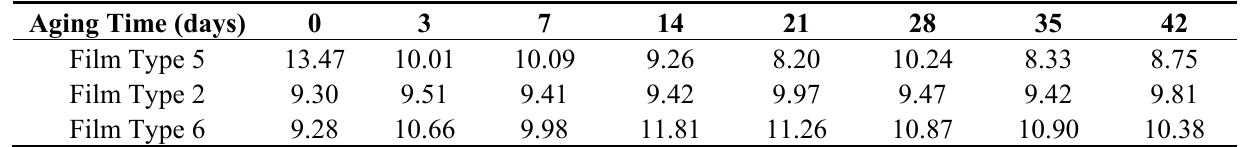
Table A5. Tensile strength (unit: ksi) vs. aging time at a 100 °C aging temperature for films with the same layer thickness, but various film thickness.